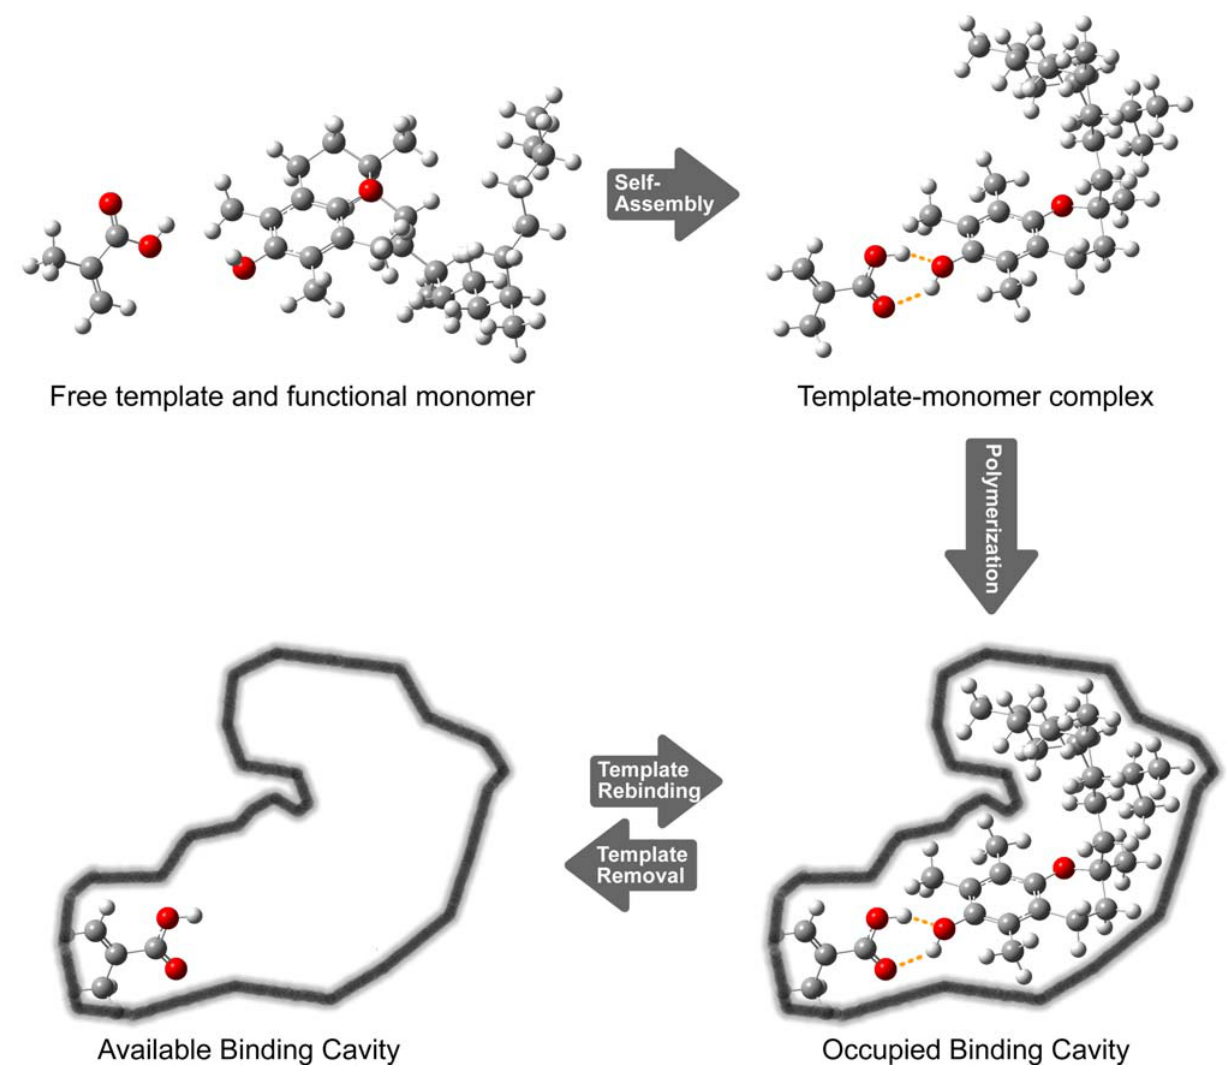
Figure 1. Schematic representation of the molecular imprinting